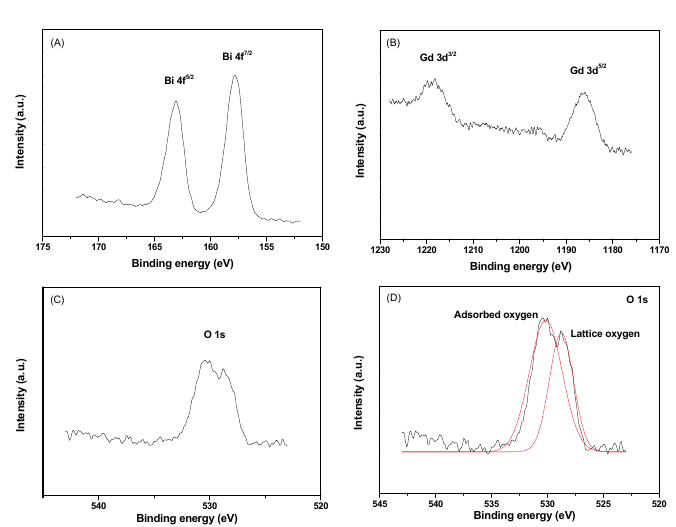
Figure 4. XPS peaks of: Bi 4f ( A ); Gd 3d ( B ); O 1s ( C ); and split of O 1s ( D ) in BiGdO 3 .